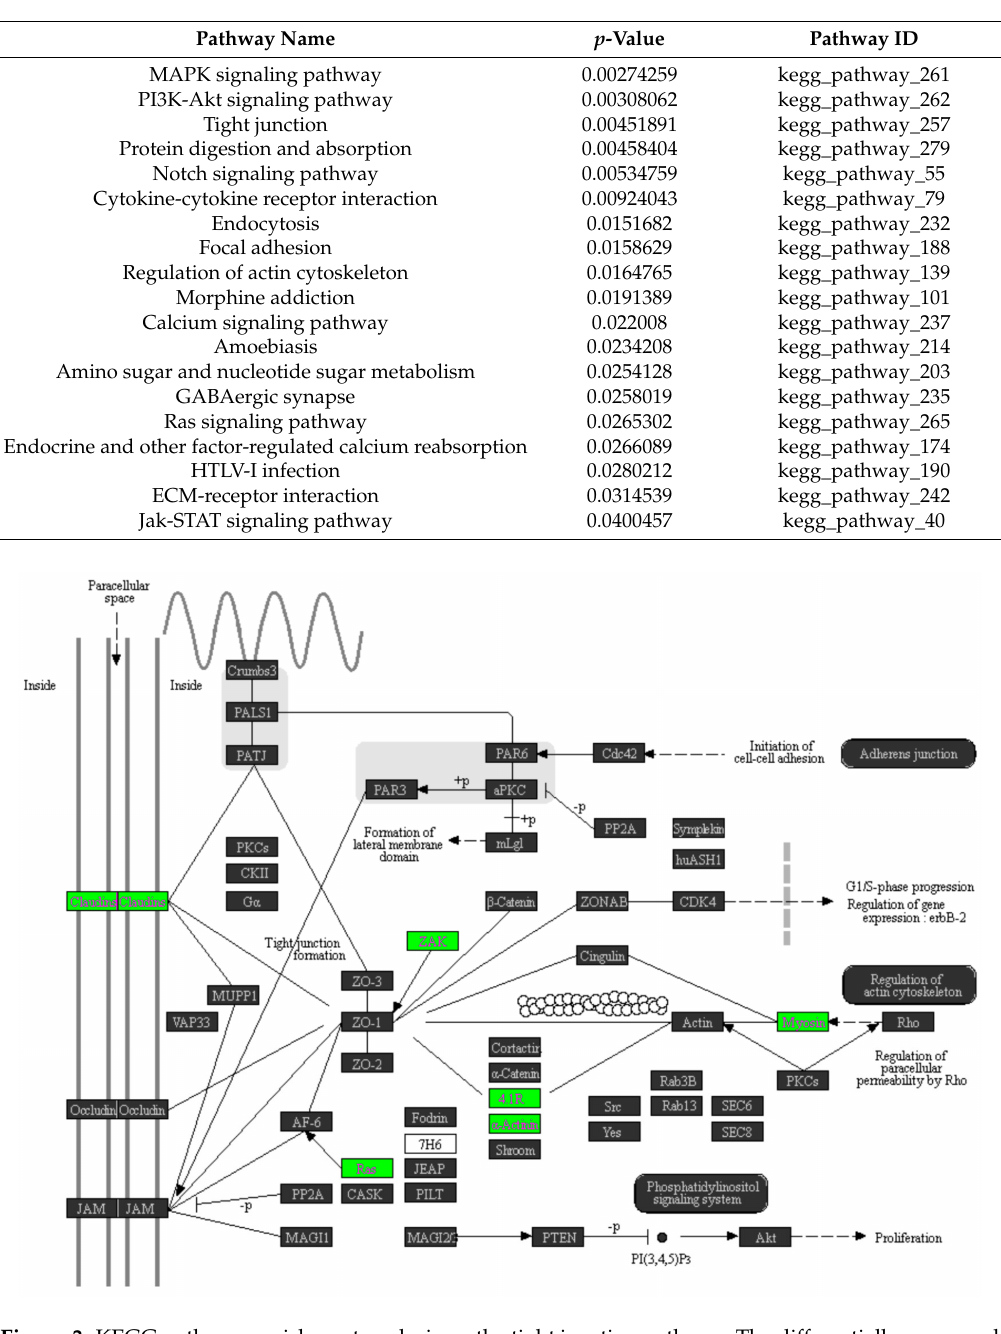
Figure 3. KEGG pathway enrichment analysis on the tight junction pathway. The differentially-expressed genes in human UTUC tumor tissues compared to adjacent normal tissues were subjected to KEGG pathway enrichment analysis using Partek Genomics software. Note that a total of six genes (highlighted in green boxes) in the tight junction pathway, including claudin-5, were significantly downregulated in UTUC tumor